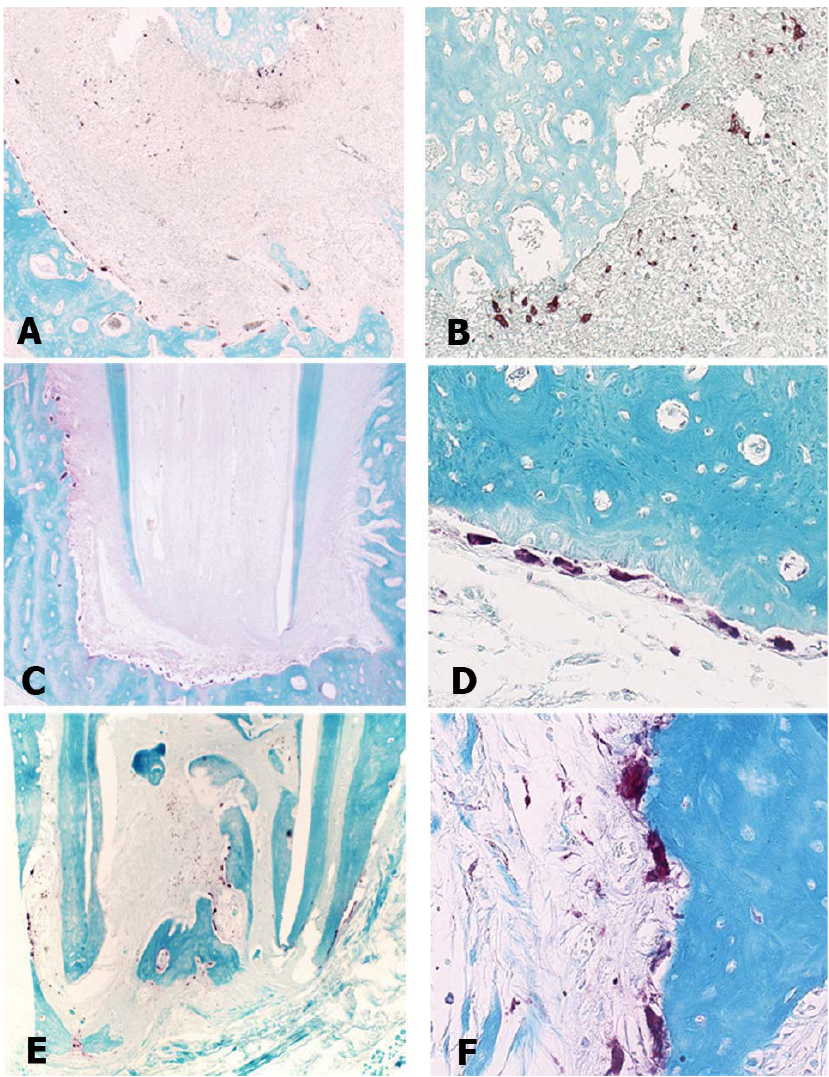
Figure 5- Photomicrographs of microscopic sections representing the 4 groups evaluated, 90 days after the endodontic treatment, stained (cid:69)(cid:92)(cid:3)(cid:55)(cid:53)(cid:36)(cid:51)(cid:3)(cid:87)(cid:72)(cid:70)(cid:75)(cid:81)(cid:76)(cid:84)(cid:88)(cid:72)(cid:3)(cid:73)(cid:82)(cid:85)(cid:3)(cid:76)(cid:71)(cid:72)(cid:81)(cid:87)(cid:76)(cid:191)(cid:70)(cid:68)(cid:87)(cid:76)(cid:82)(cid:81)(cid:3)(cid:68)(cid:81)(cid:71)(cid:3)(cid:70)(cid:82)(cid:88)(cid:81)(cid:87)(cid:3)(cid:82)(cid:73)(cid:3)(cid:82)(cid:86)(cid:87)(cid:72)(cid:82)(cid:70)(cid:79)(cid:68)(cid:86)(cid:87)(cid:76)(cid:70)(cid:3)(cid:70)(cid:72)(cid:79)(cid:79)(cid:86)(cid:29)(cid:3)(cid:11)(cid:36)(cid:12)(cid:3)(cid:53)(cid:72)(cid:83)(cid:85)(cid:72)(cid:86)(cid:72)(cid:81)(cid:87)(cid:68)(cid:87)(cid:76)(cid:89)(cid:72)(cid:3) (cid:83)(cid:75)(cid:82)(cid:87)(cid:82)(cid:80)(cid:76)(cid:70)(cid:85)(cid:82)(cid:74)(cid:85)(cid:68)(cid:83)(cid:75)(cid:86)(cid:3) (cid:82)(cid:73)(cid:3) (cid:87)(cid:75)(cid:72)(cid:3) (cid:36)(cid:83)(cid:76)(cid:70)(cid:68)(cid:79)(cid:3) (cid:51)(cid:72)(cid:85)(cid:76)(cid:82)(cid:71)(cid:82)(cid:81)(cid:87)(cid:76)(cid:87)(cid:76)(cid:86)(cid:3) group, where it was observed that the apex and alveolar bone had intense presence of osteoclasts (Zeiss, 5X). (B) Image A detail, highlighting intense presence of osteoclasts (Zeiss, 20X). (C) Representative photomicrographs of healthy teeth group, where there is healthy tissues with reduced presence of osteoclasts (Zeiss, 5X). (D) Representative photomicrograph of the conventional irrigation group. The surface of the alveolar bone showing moderate presence of osteoclasts, albeit in larger quantity than in the ANP group (Zeiss, 40X). (E) Representative photomicrograph of the ANP group with slightly increased presence of osteoclasts (Zeiss, 5X). (F) Detail of image E, highlighting the osteoclasts in the bone surface (Zeiss,